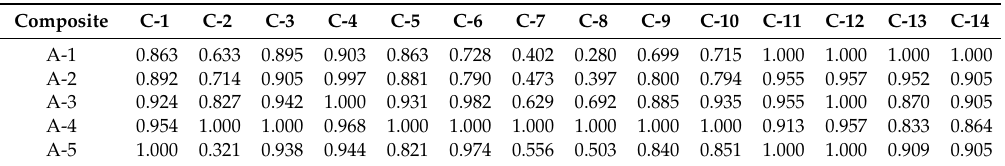
Table 4. Normalized decision matrix.